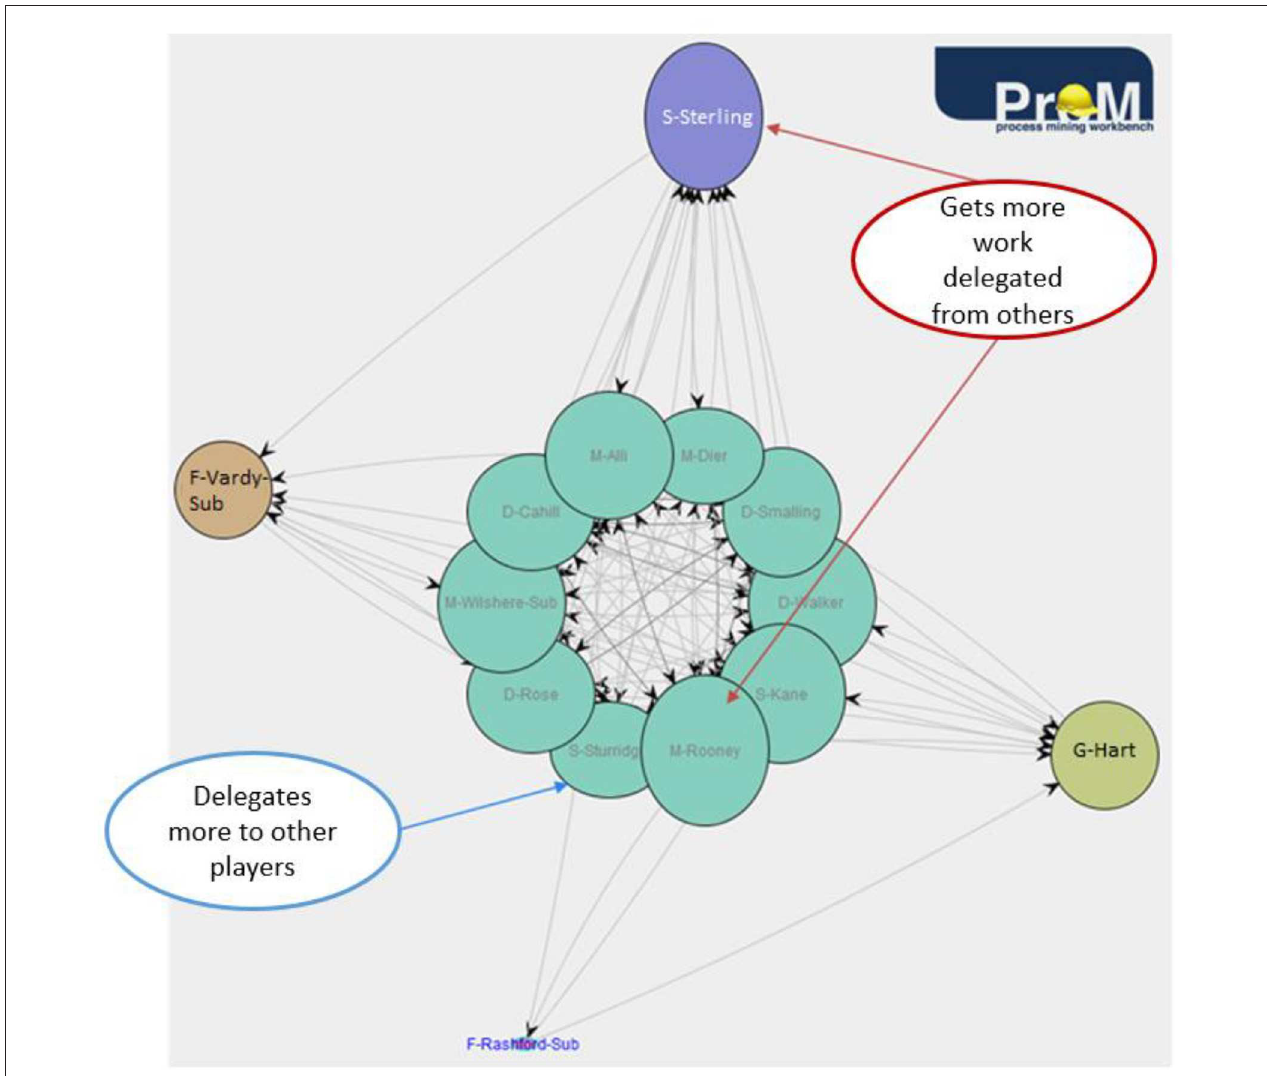
FIGURE 10 | England–handover of